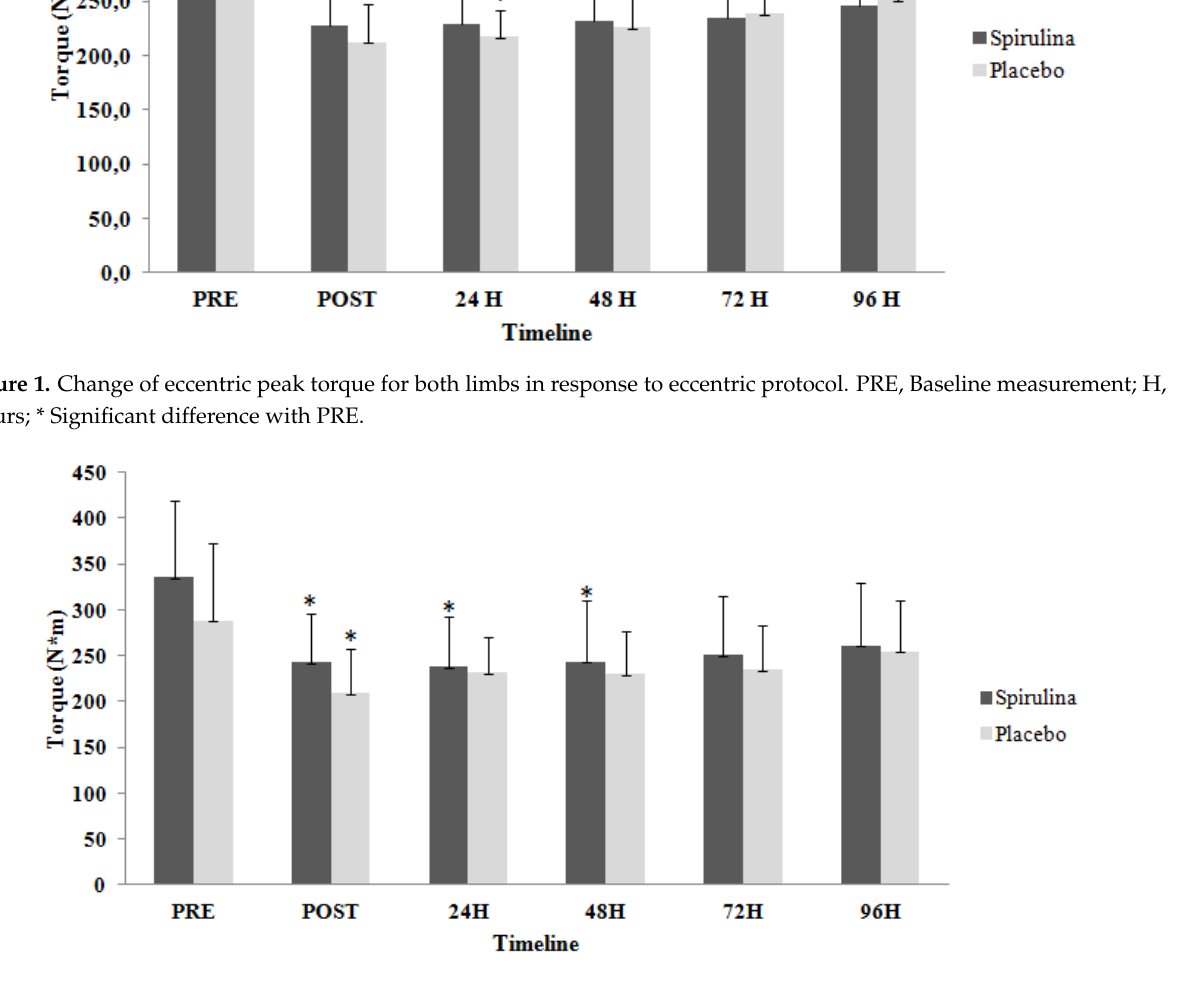
Figure 2. Change of eccentric peak torque for right limb in response to eccentric protocol. PRE, Baseline measurement; H, Hours; * Significant difference with PRE.